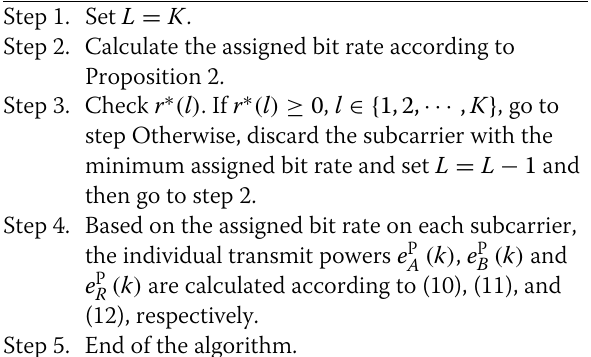
Algorithm 1 JPCBRA minimizing the network transmit